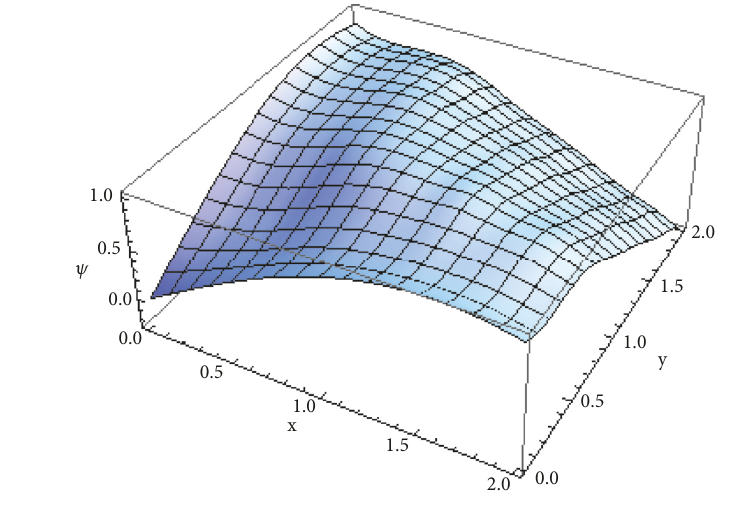
Figure 8: Imaginary solution of the two-dimensional wave function obtained by